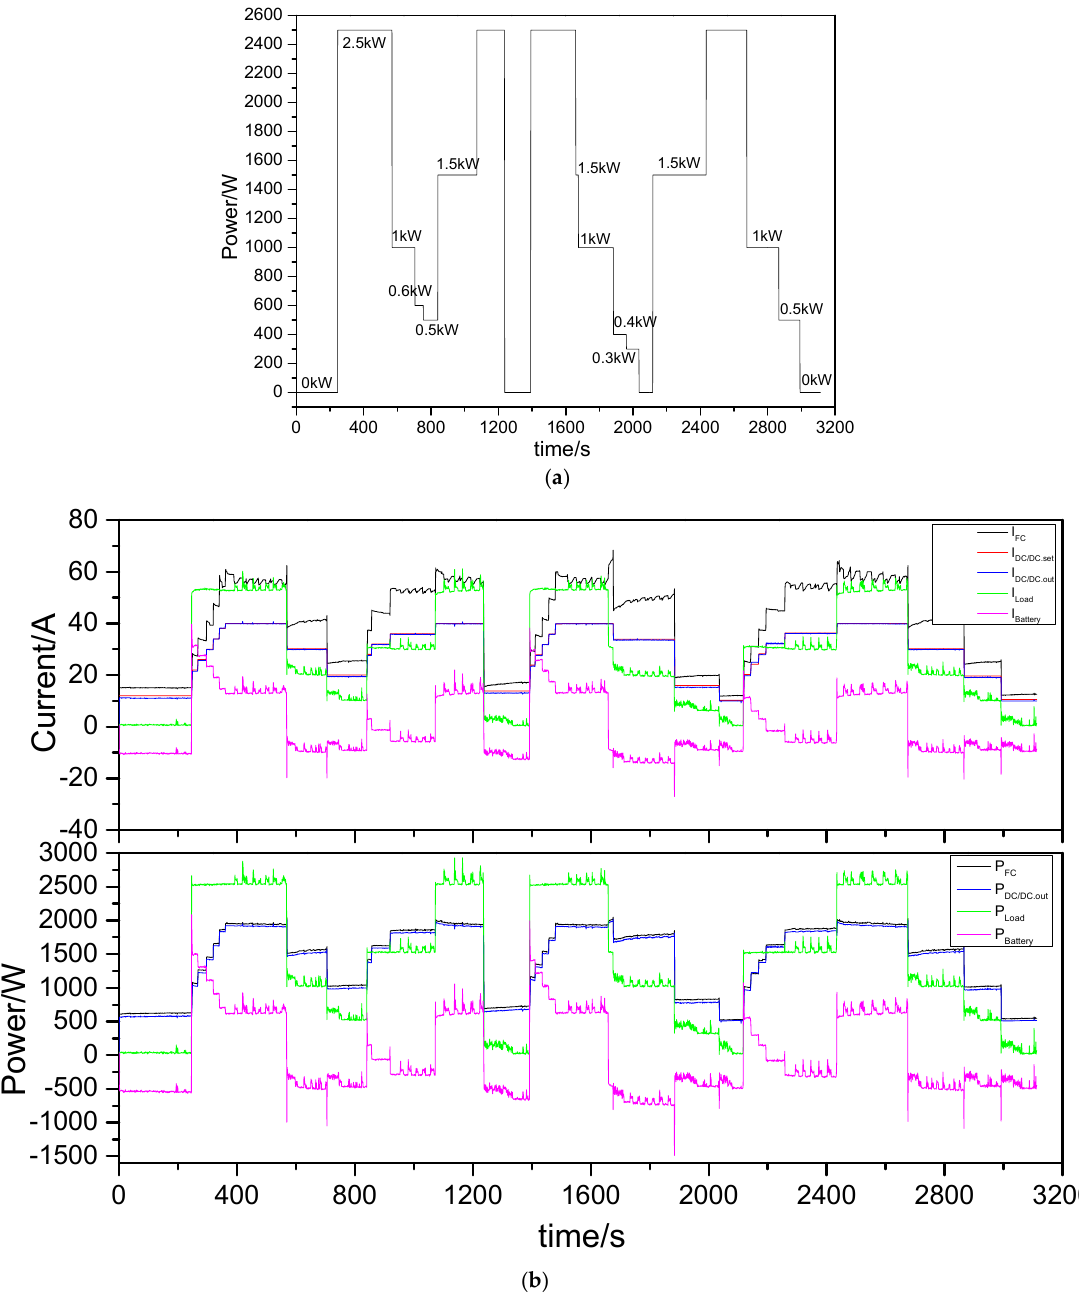
Figure 14. Response test when the load power is frequent change. ( a ) Request curve of load power; and ( b ) the response curve of current and power. and ( b ) the response curve of current and